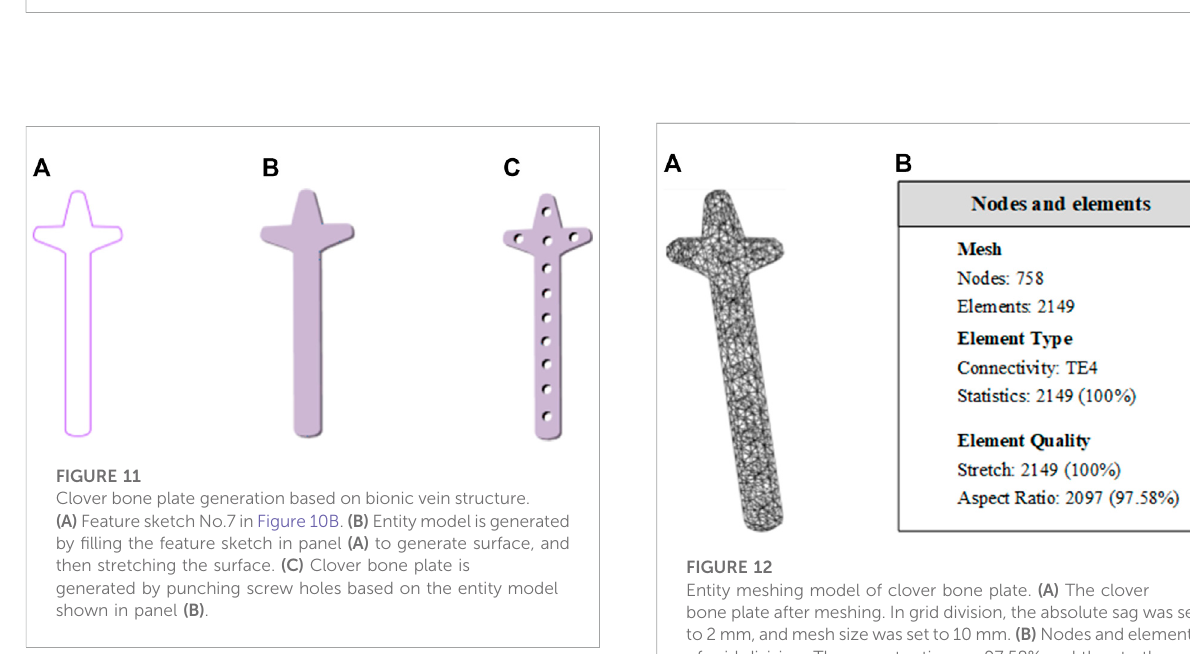
FIGURE 11 Clover bone plate generation based on bionic vein structure. (A) FeaturesketchNo.7inFigure 10B. (B) Entitymodelisgenerated by fi lling the feature sketch in panel (A) to generate surface, and then stretching the surface. (C) Clover bone plate is generated by punching screw holes based on the entity model shown in panel (B) .